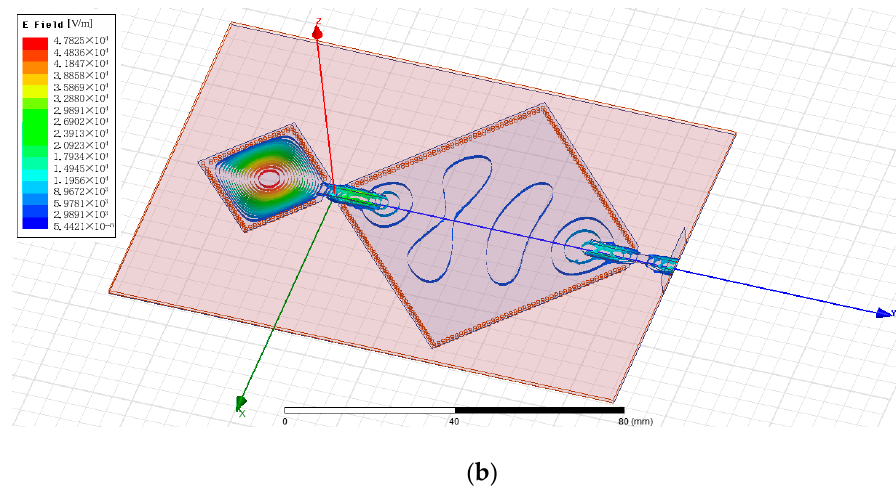
Figure 2. Distribution of electric field of the proposed SIW at ( a ) 2.45 GHz and ( b ) 5.85 GHz.